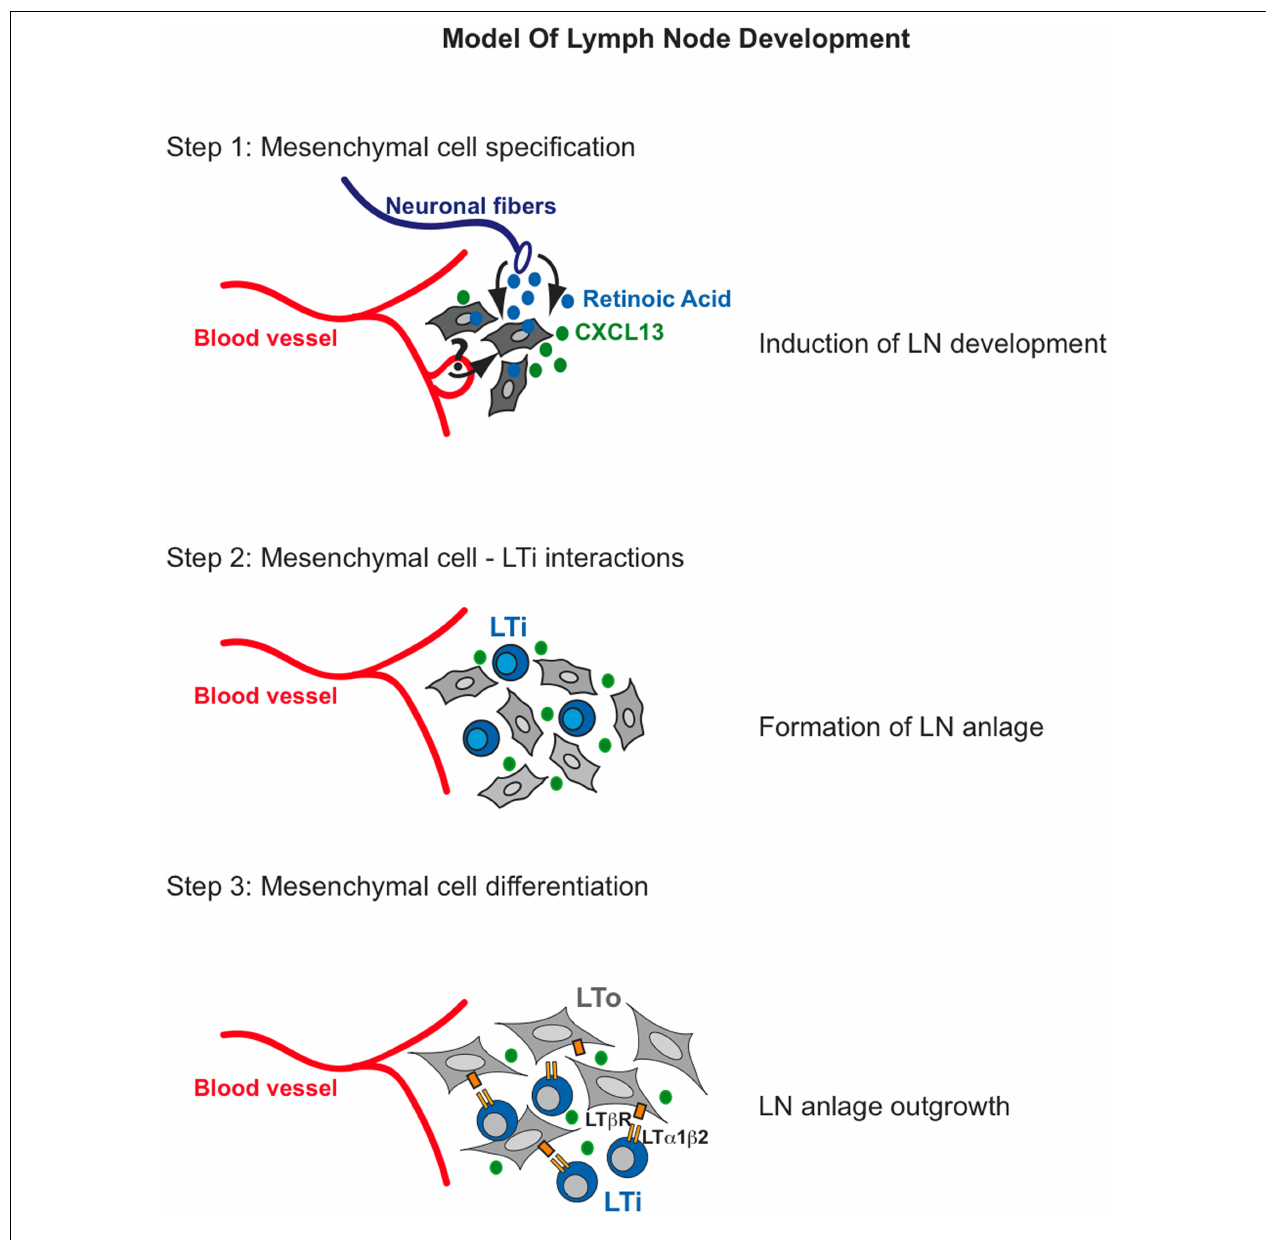
high expression levels of LT α 1 β 2. Binding of the latter to LT β R on mesenchymal cells will induce the expression of cell adhesion molecules VCAM-1, ICAM-1, and MAdCAM-1 as well as CXCL13, CCL21, and CCL19 to initiate a positive feedback loop that will attract large numbers of